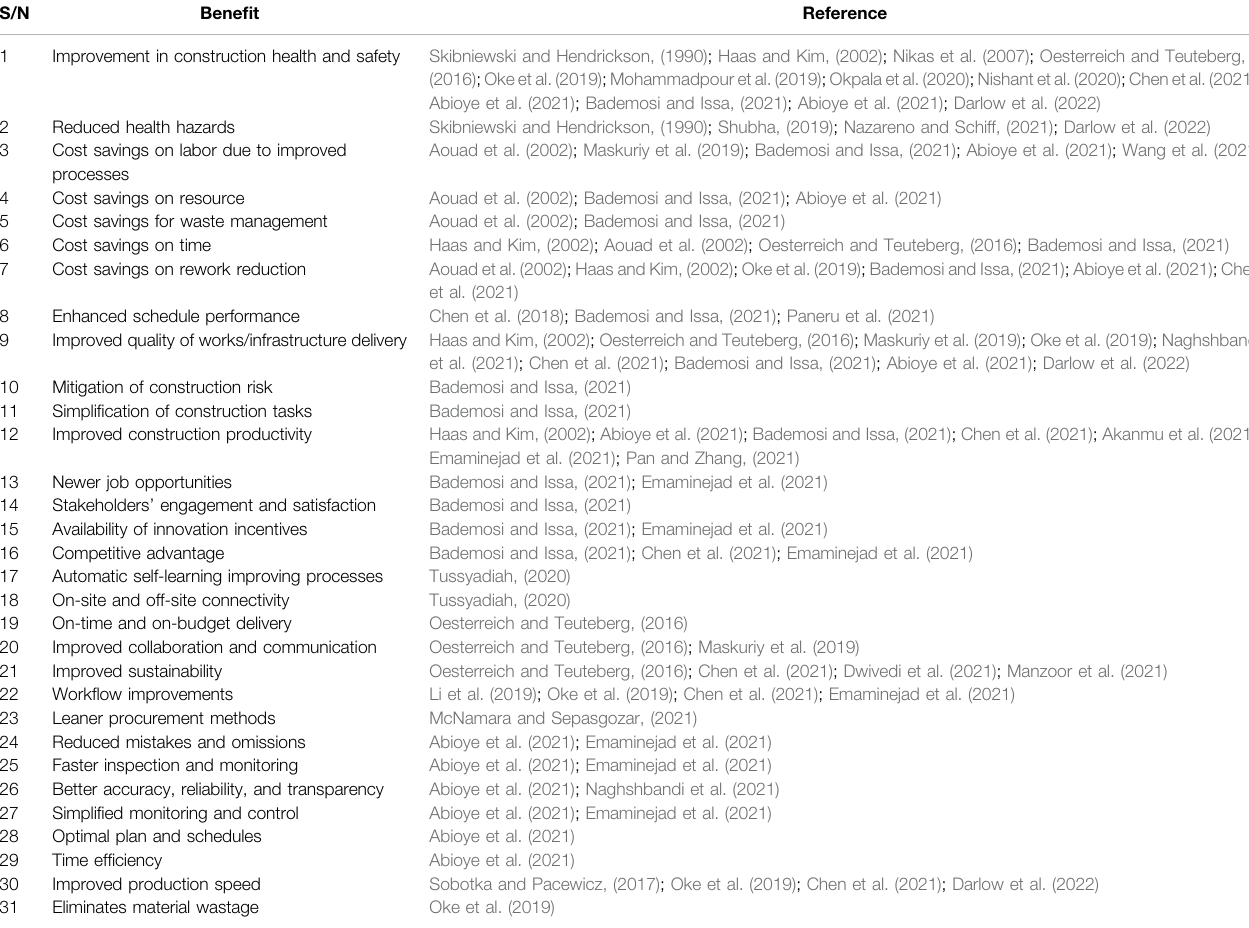
TABLE 1 | Bene fi ts of automation and arti fi cial intelligence. S/N Bene fi